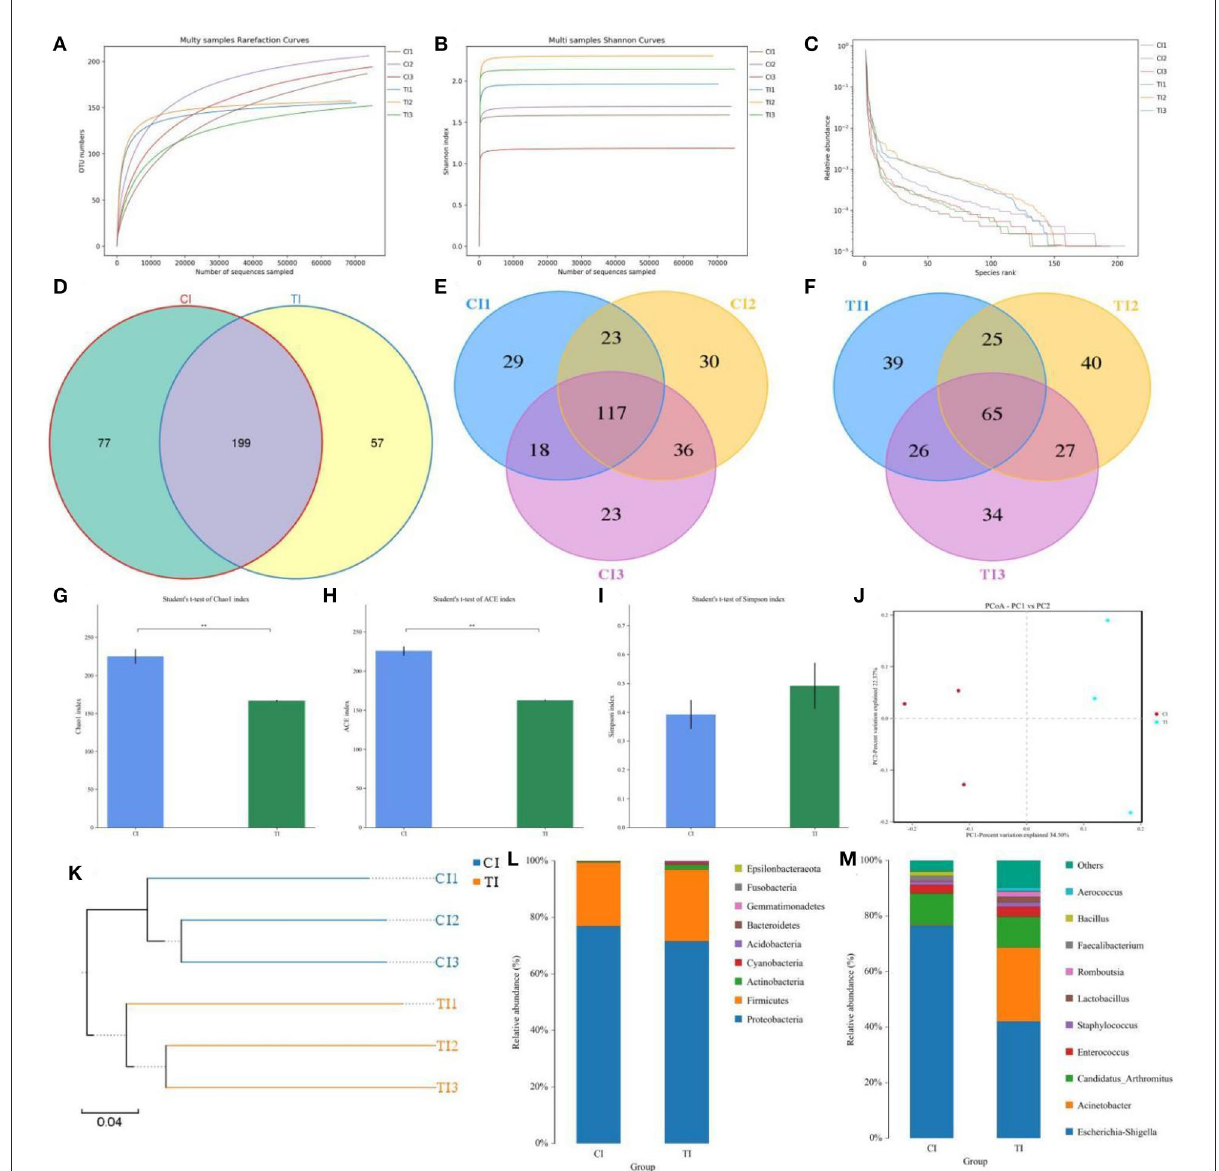
FIGURE2 Thiram exposure changed the gut microbial composition and diversity of chickens. (A,B) Rarefaction curves. (C) Rank abundance curve. (D–F) Venn diagrams. (G–I) Chao1, ACE, and Simpson indices were employed to evaluate gut microbial alpha diversity. (J) PCoA map based on the unweighted UniFrac distance. (K) Clustering analysis. (L,M) Relative proportion of preponderant bacteria at the phylum and genus levels.